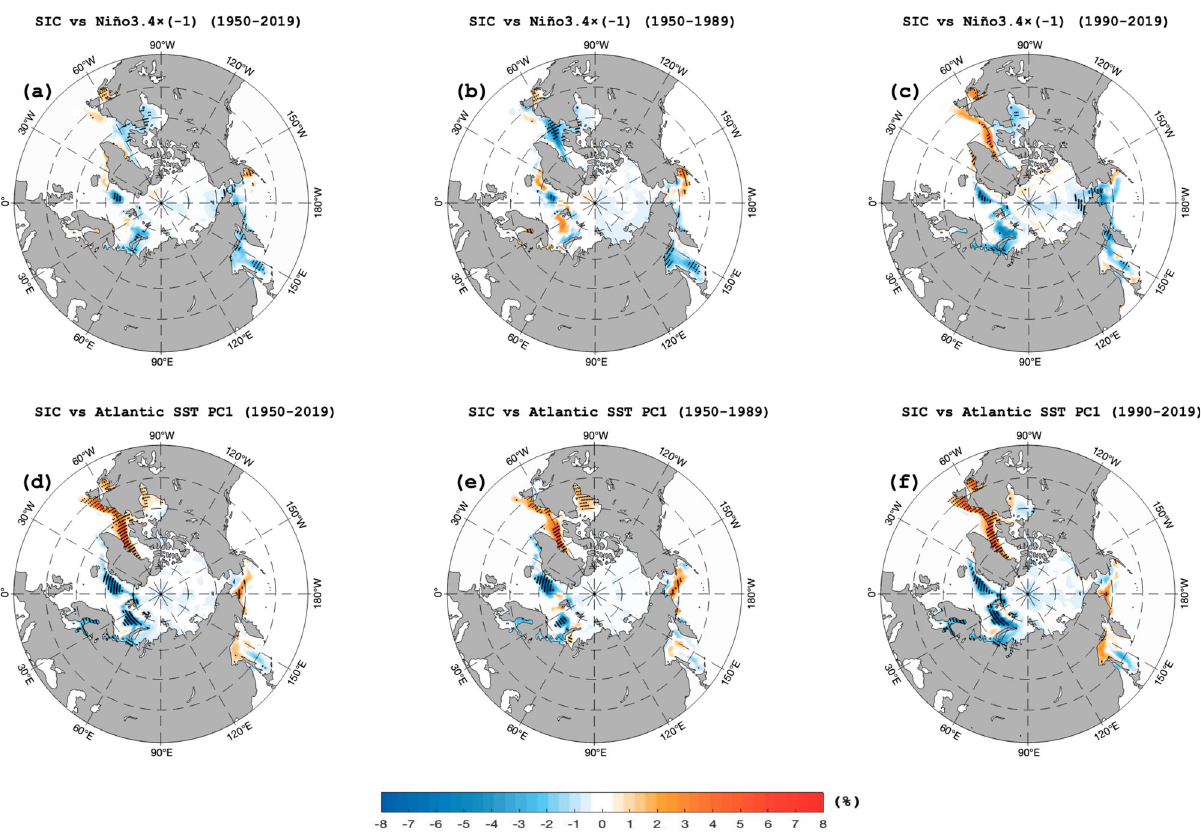
Fig. 4 | Spatial patterns of winter sea ice concentration (SIC) anomalies in response to the interannual variations of the winter Niño3.4 index and North Atlantic sea surface temperature (SST). a – f DJF (December-February) mean SIC anomalies (unit: %) regressed onto the 9-year high pass fi ltered normalized DJF-